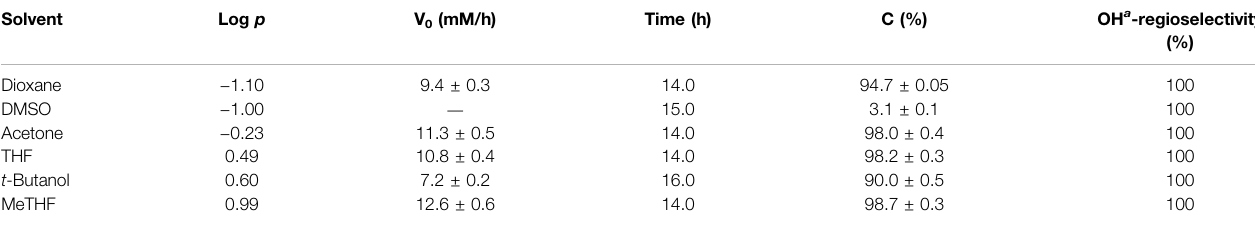
TABLE 2 | Effect of organic solvents on Fe 3 O 4 -PDA-TLL-catalyzed decanoylation of polydatin.: Solvent Log